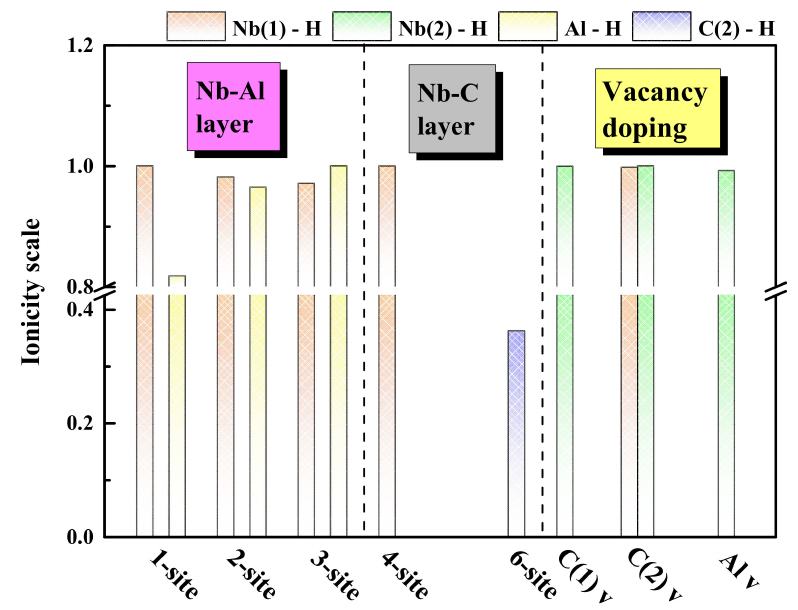
Figure 9. Ionicity scale Pi of Nb, Al, C–H bonds in Nb 4 AlC 3 MAX phases.